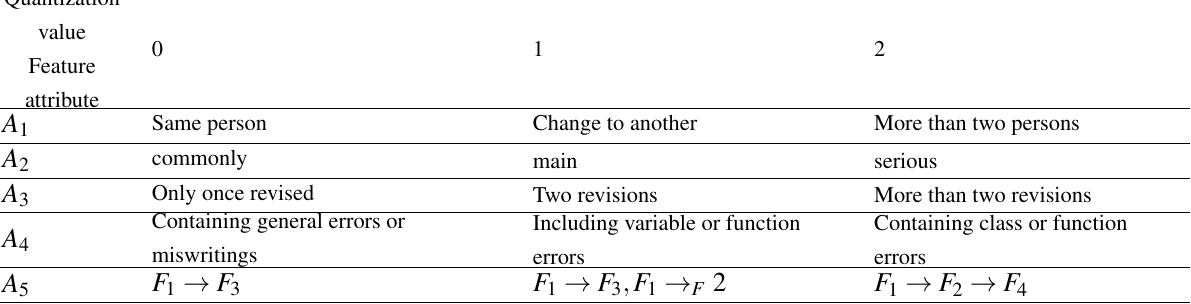
Table 3 Discrete Processing of Characteristic Attributes Quantization